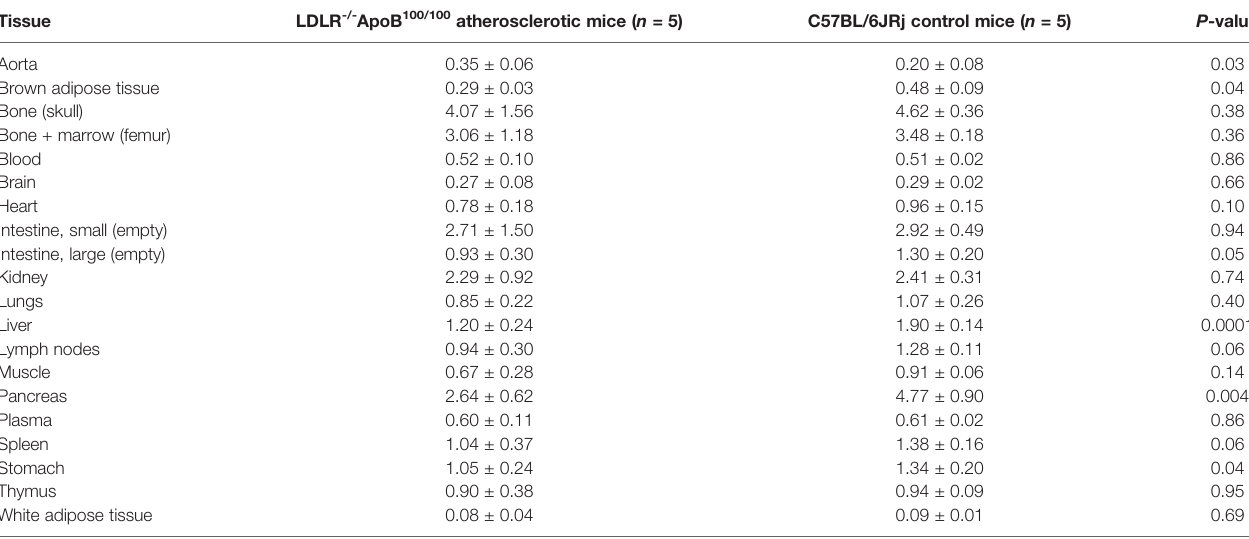
TABLE 2 | Ex vivo biodistribution of 18 F-FGln at 70 minutes post-injection into mice (expressed as SUV). Tissue LDLR -/- ApoB 100/100 atherosclerotic mice ( n =